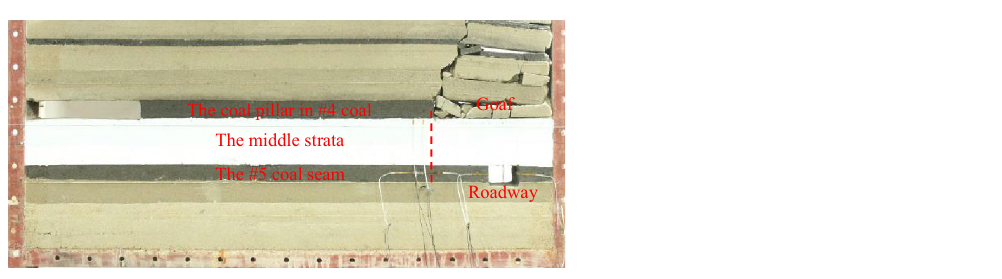
Figure 11. Deformation observation of roadway surrounding rock at construction site.